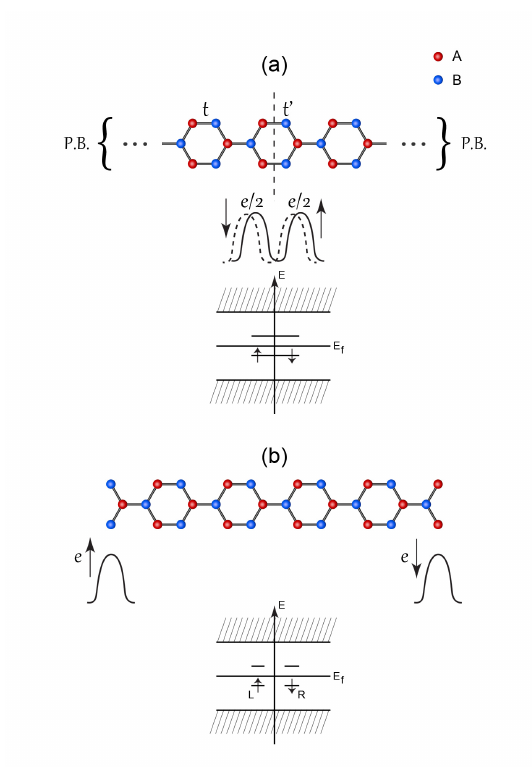
Figure 8. ( a ) Periodic armchair graphene nanoribbon (AGNR) with shortest width and modified hopping t (cid:48) between two neighboring zigzag edges at center. P.B. represent periodic boundary conditions. A schematic illustration of the probability densities of the soliton gap states is also shown. Some overlap between its left and right probability densities occurs if the hopping between these two edges, i.e., t (cid:48) , is non-zero. The energy spectrum of the gap states for a finite on-site electron repulsion U is also shown. In the limit of small U , the energy splitting of the solitonic gap states vanishes and the energies approach zero. ( b ) In the limit t (cid:48) 0 (corresponding to cutting of the bond), a rectangular → AGNR is realized. The solutions change qualitatively: antiferromagnetically coupled integer charges develop that are localized on the left (L) and right (R) zigzag edges.